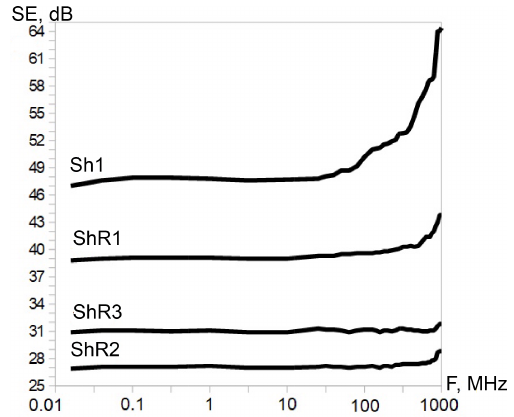
Figure 8. Dependence of the shielding effectiveness (SE) of shun- gite rocks on the electromagnetic field frequency (in MHz). SE is in decibels (dB), a relative unit of measurement that expresses the ratio of two values of a power quantity on a logarithmic